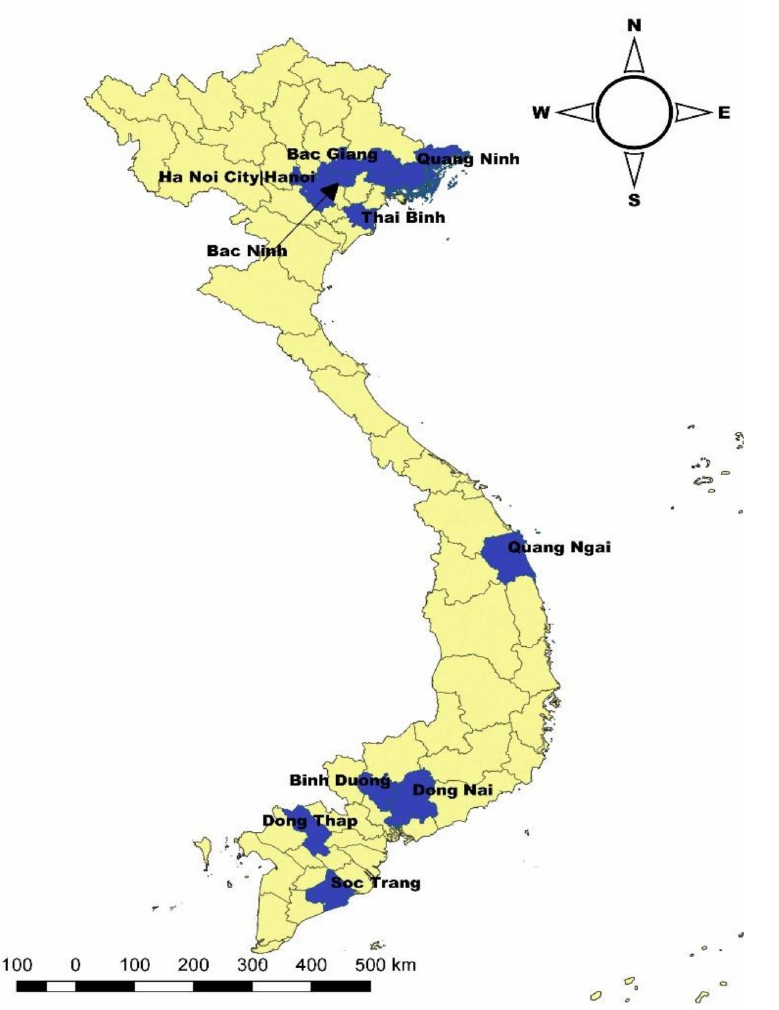
Fig 1. Selected sampling provinces (in blue) for leptospirosis and JE in